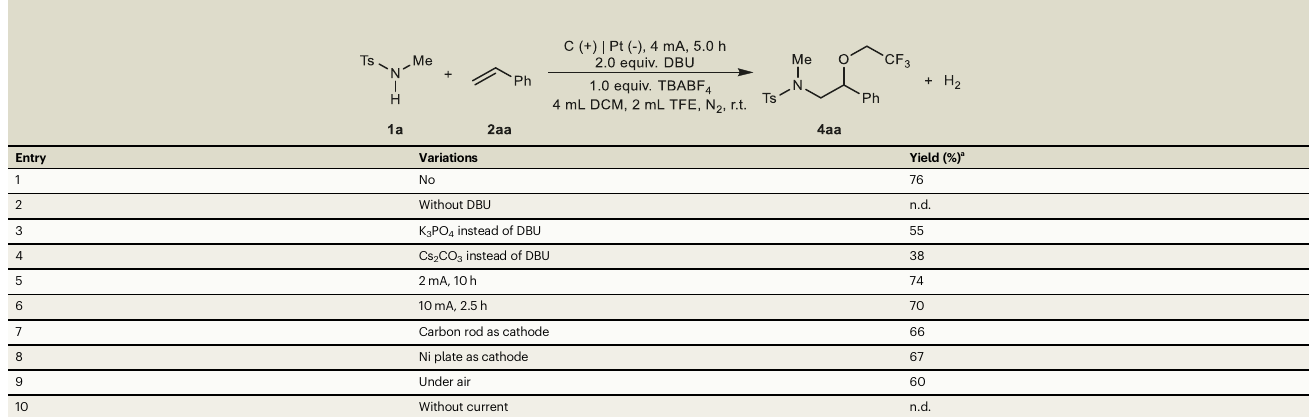
Table 1 | Optimization of the electro-oxidative 1,2-amino oxygenation of alkenes